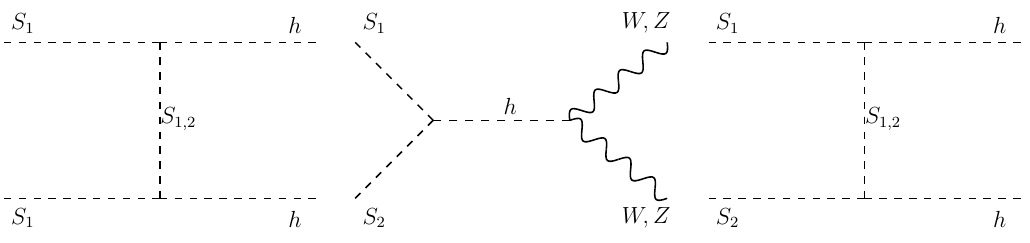
Figure 10 . Dark matter S 1 annihilation (left) and S 1 − S 2 coannihilation (center and right) processes involving the λ 6 and λ SB